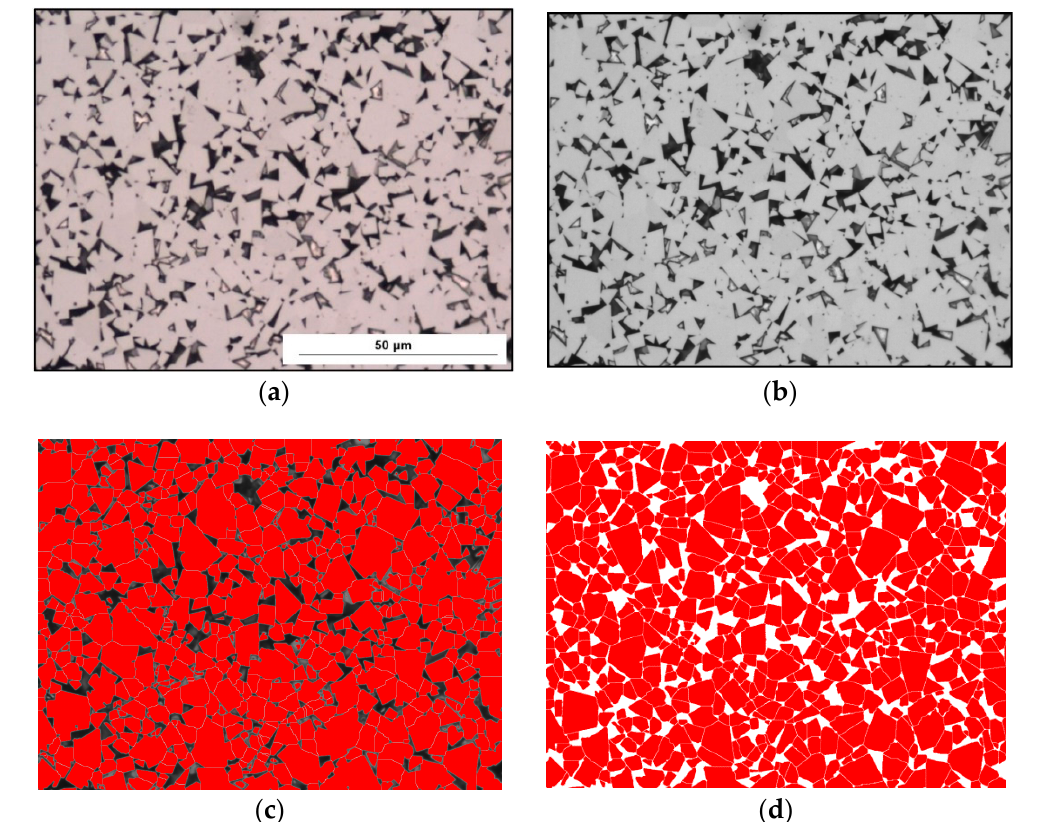
of the carbides is presented in Figure 6.